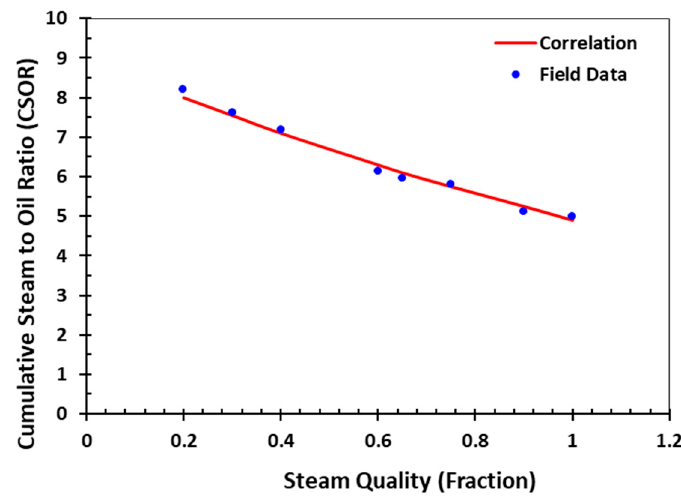
Figure 5. CSOR vs. steam quality for the database analyzed.